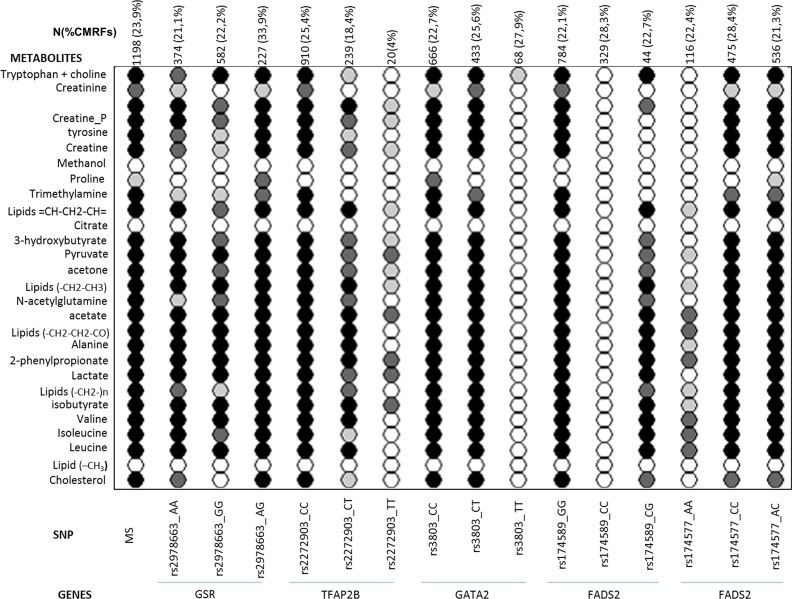
Patterns of statistical significance, calculated as p-values, for the comparison of metabolic profiles from subjects group 1 versus subjects from group 3 in the whole population (first column) and in individuals with different SNPs (rest of the columns).(white) p> 0.01; (white-gray) p< 0.01; (gray) p< 0.001; (black) p< 0.00001.